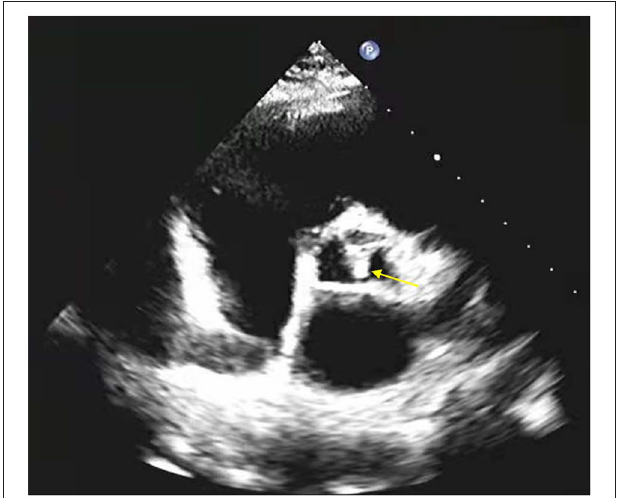
FIGURE 2 | Example of echocardiogram showing calcification of the aortic valve (yellow arrow).